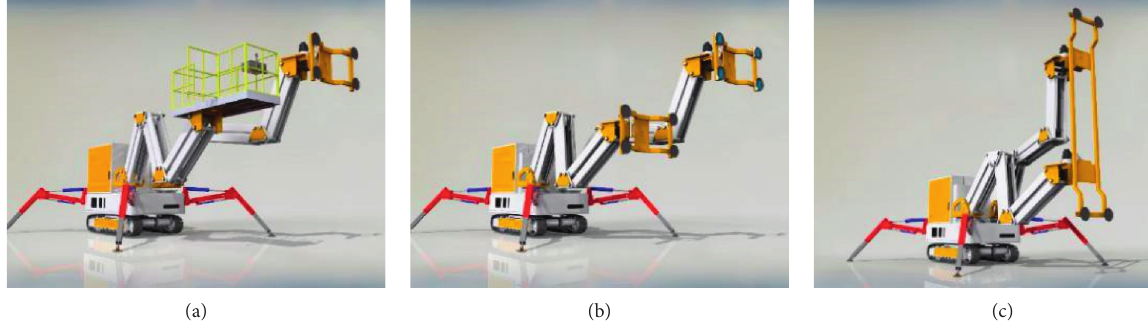
Figure 2: Three main working